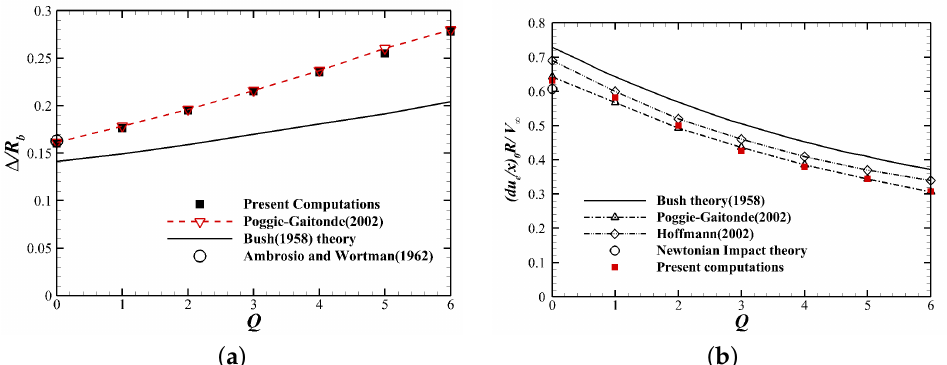
Figure 5. Effect of external magnetic field: ( a ) Shock stand-off distance, γ = 1.4. ( b ) Velocity gradient at stagnation point.